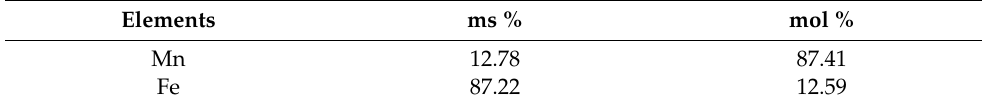
Table 2. The content of Mn and Fe in the Mn